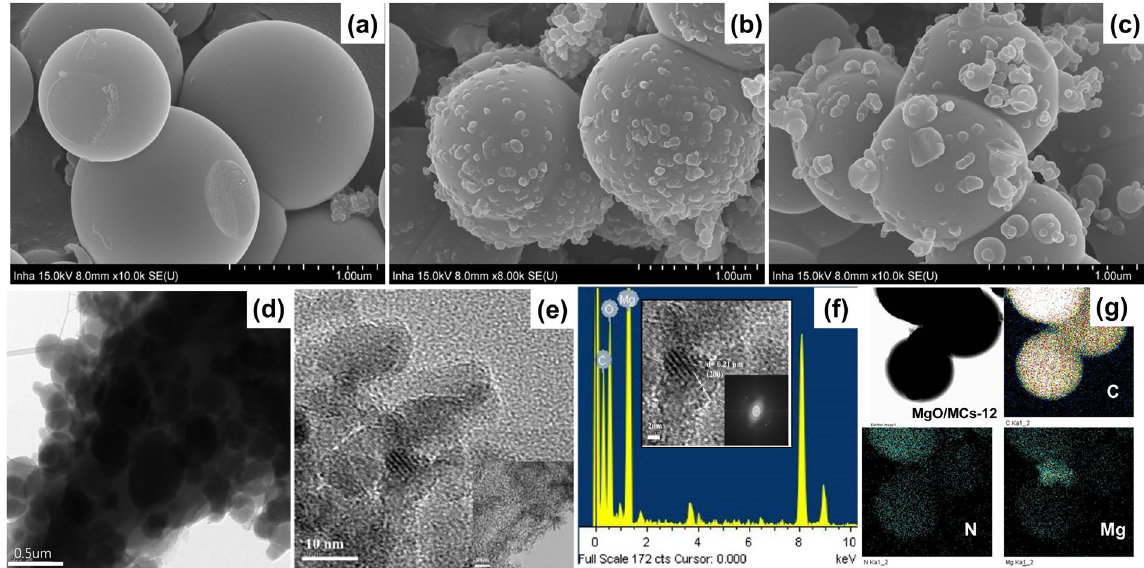
Figure 3. HR-SEM images of ( a ) MCs, ( b ) MgO/MCs-12, and ( c ) Mg/MCs-17. FE-TEM images of ( e ) MCs and ( f ) MgO/MCs-12, ( g ) EDS spectrum (Inset: small crystalline MgO particles) and ( h ) elemental mapping of MgO/MCs-12, C, N, and Mg, respectively.